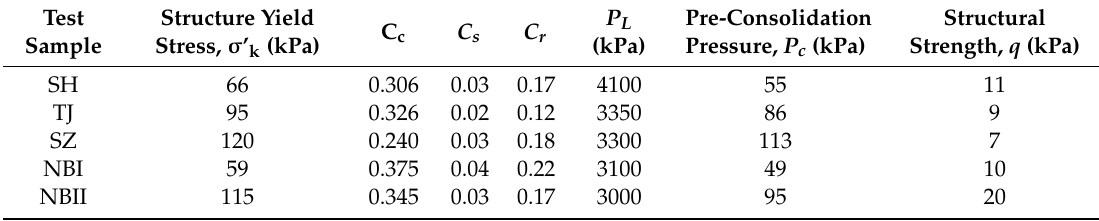
Table 7. Parameters of one-dimensional compression tests.